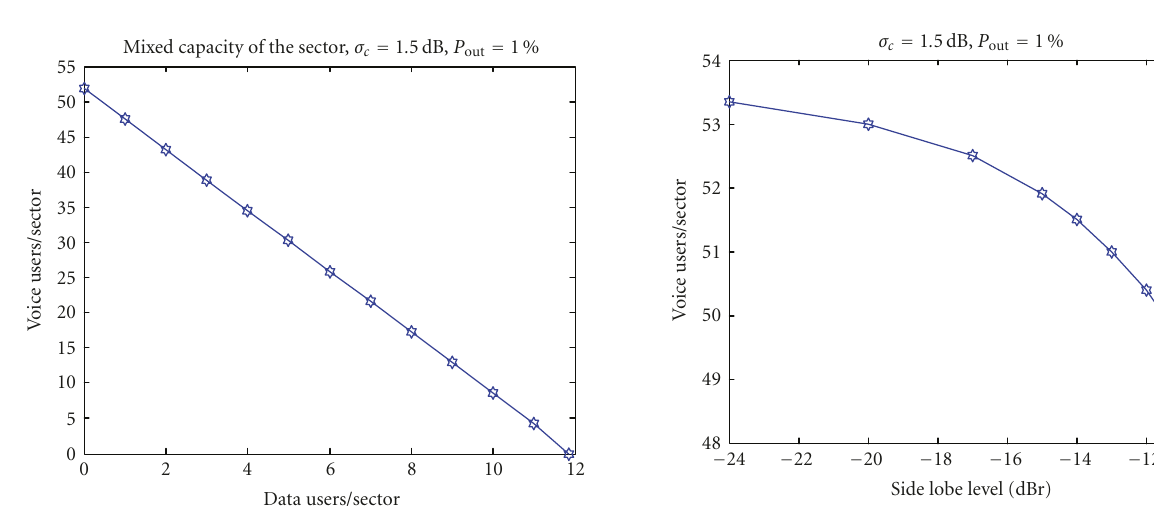
Figure 8: Sector capacity for di ff erent R for (voice users only, mixed services (voice users +5 data users), and data users only).